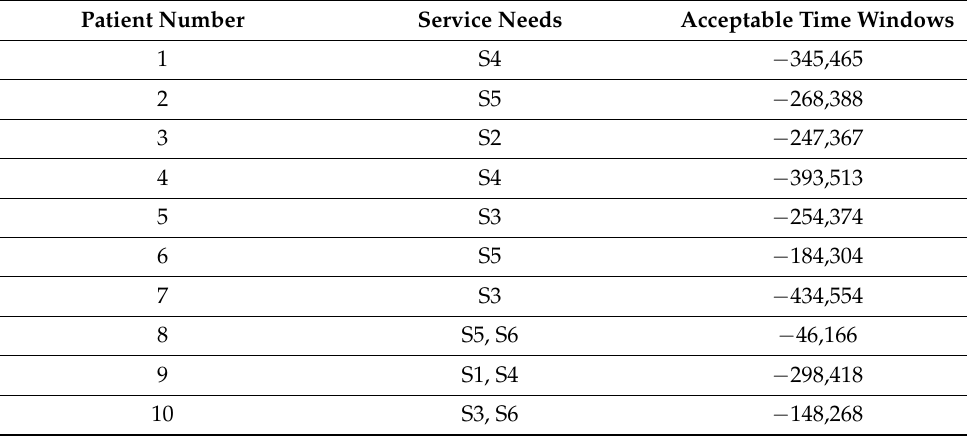
Table A1. Sample patient properties for the first category instance.